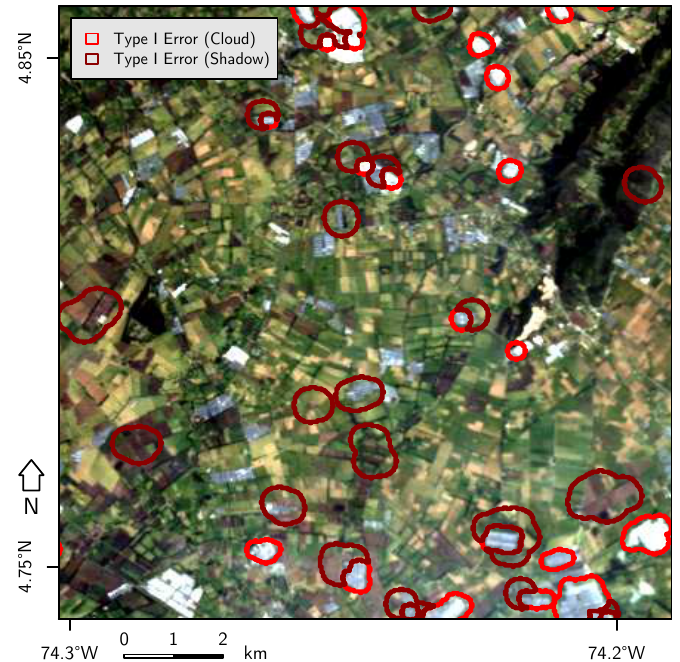
Figure 4. Landsat image with cloud and cloud shadow mask depicting the agriculturally used part of the Sabana de Bogotá in the northern part of the city of Bogotá. There are no clouds in the image, but fmask misclassified certain areas as clouds. Mostly, these areas are related to greenhouses (data source: Landsat 22 December 1989 TM RGB